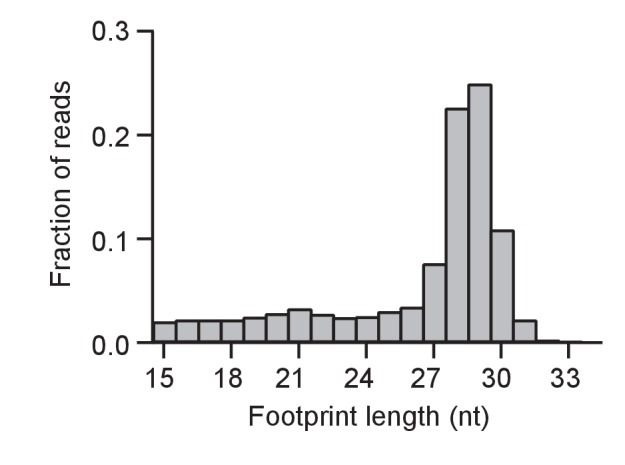
Size distribution of ribosome footprints as in Fig.Figure 2A for a baseline control (WT cells without DTT).